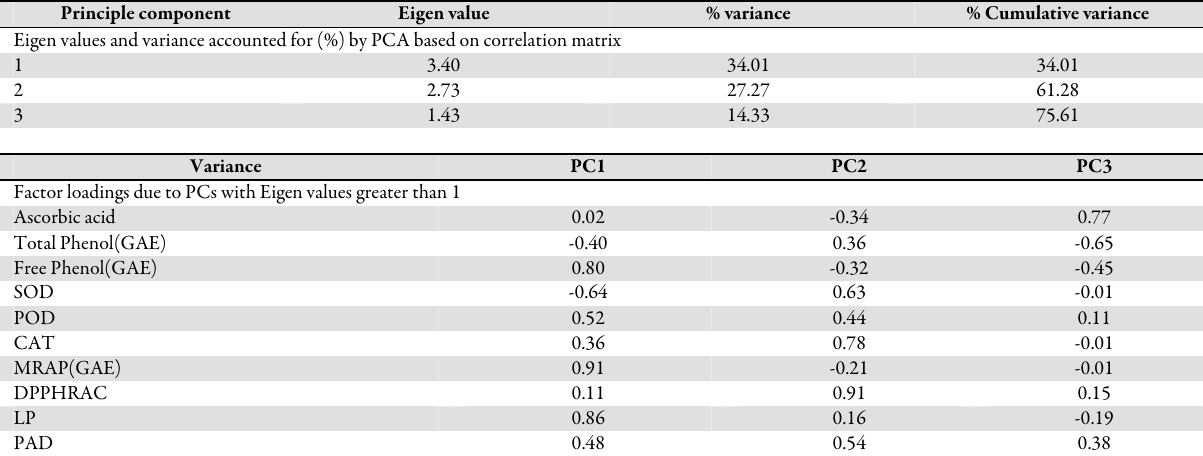
Table 3. Results of principal component analysis (PCA) for effect of Zn and B on antioxidants content and antioxidant activity along with pyruvic acid development in